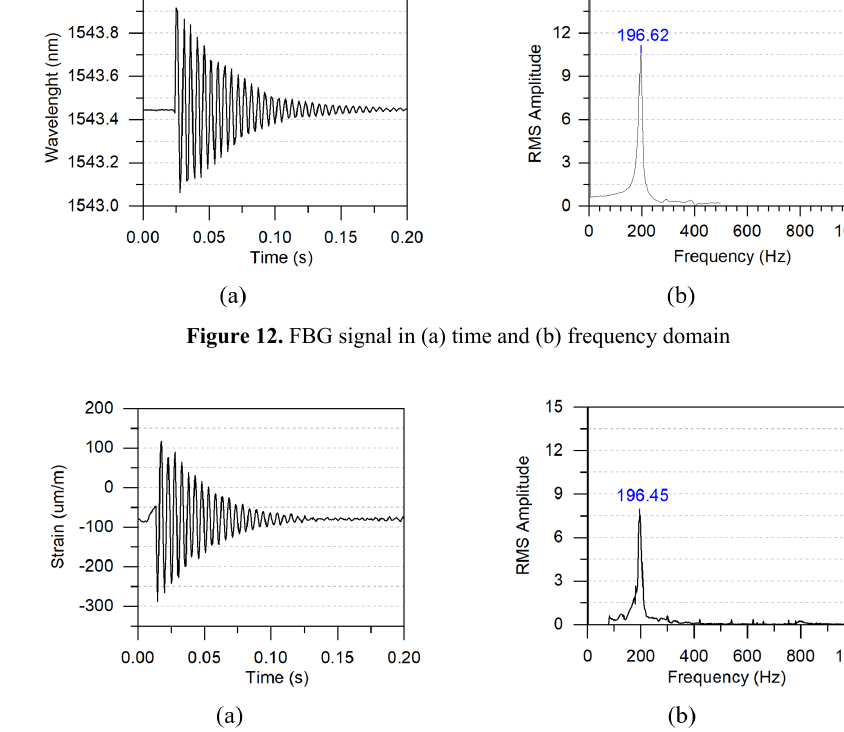
Figure 13. Strain gauge signal in (a) time and (b) frequency domain